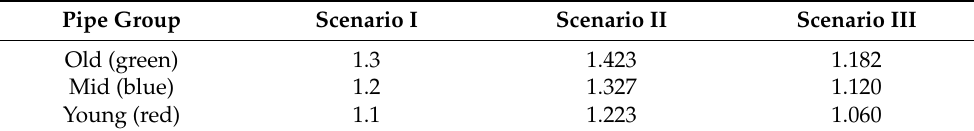
Table 4. Values of α in three scenarios.